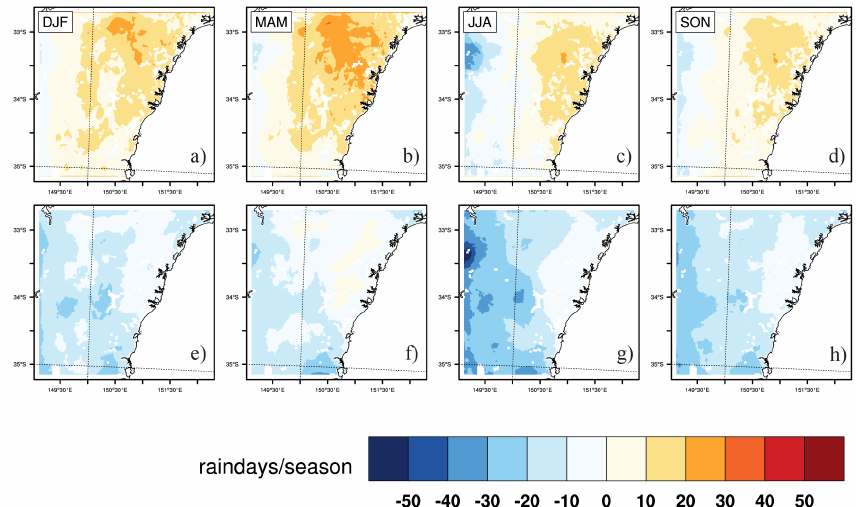
Fig. 5. Seasonal biases in the number of wet days in the WRF simulation at 2km with respect to GHCN (a – d) and AWAP (e – h) .